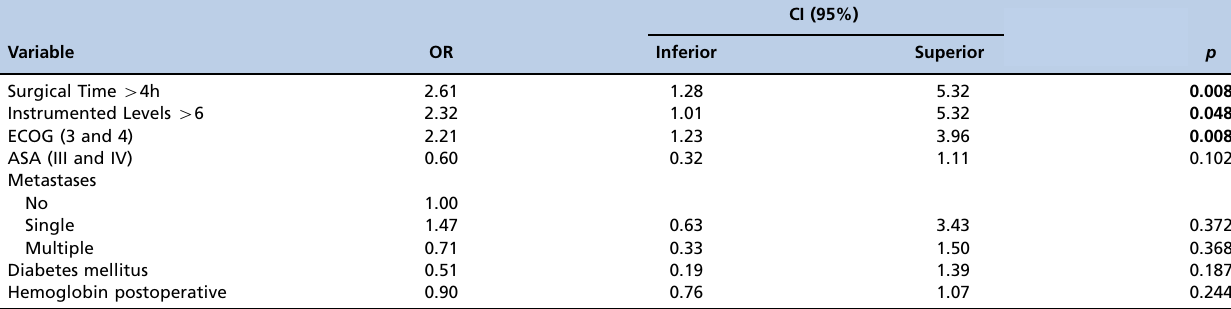
Table 4 - Description of revised Tokuhashi score system according to the occurrence of infection and intrahospital mortality of patients and the results of comparisons. Variable